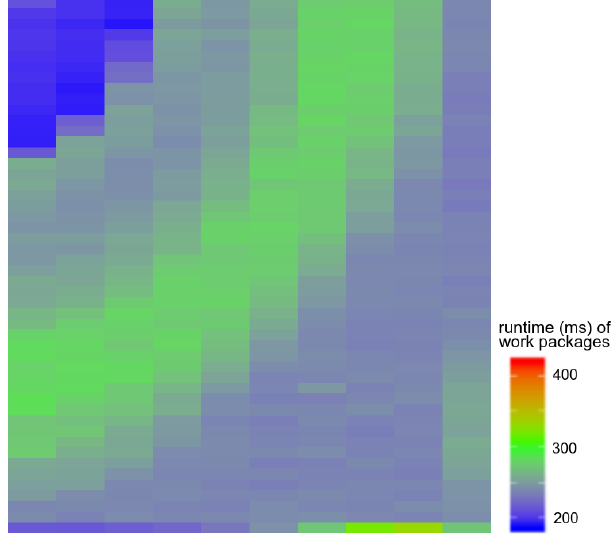
Figure 2. Runtimes for single work packages composed of 5 con- tiguous cells in an exemplary 2D 50 × 50 simulation. Chemistry is more computationally intensive near the reaction front, and contigu- ous domain partitioning can therefore suffer from suboptimal load balance.